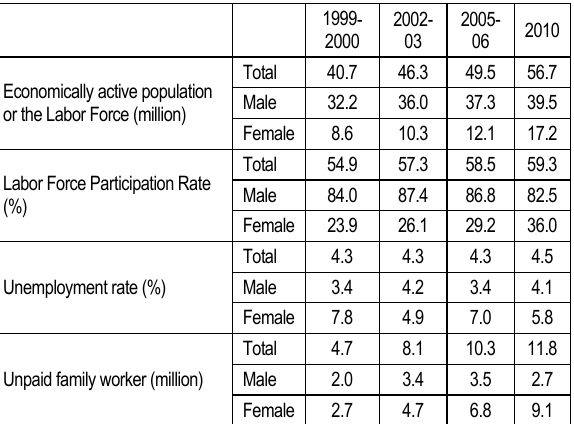
Table 1. Labor Force